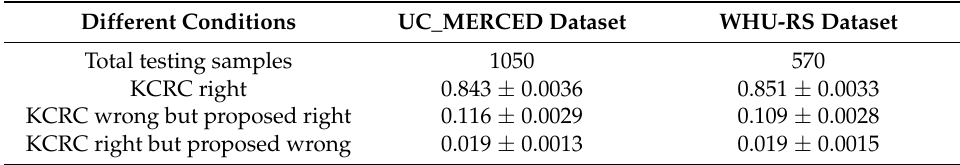
Table 3. Classification results of both datasets with KCRC and our proposed algorithm.